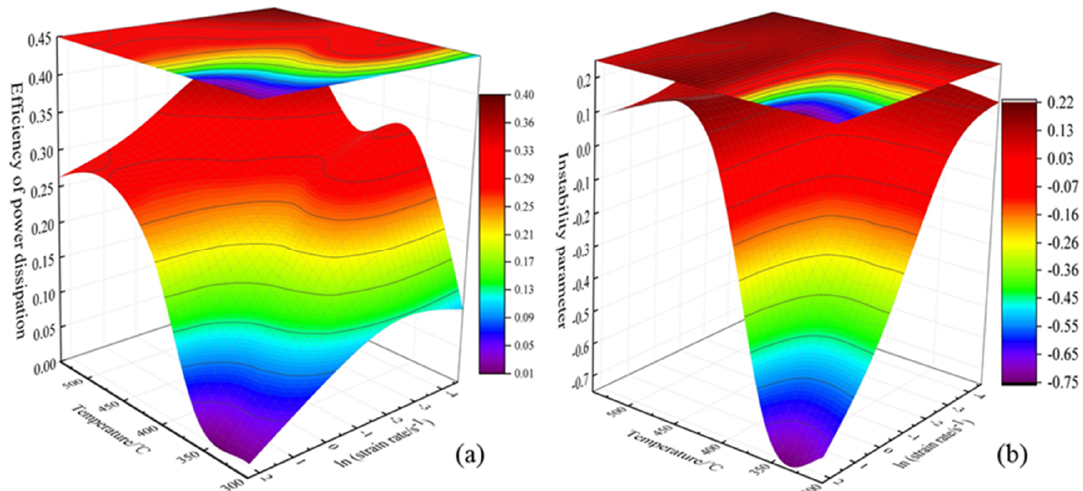
Figure 5. 3D processing map drawn through power dissipation factor η with the true strain ε = 0.7. ( a ) power dissipation map; ( b ) flow instability map.